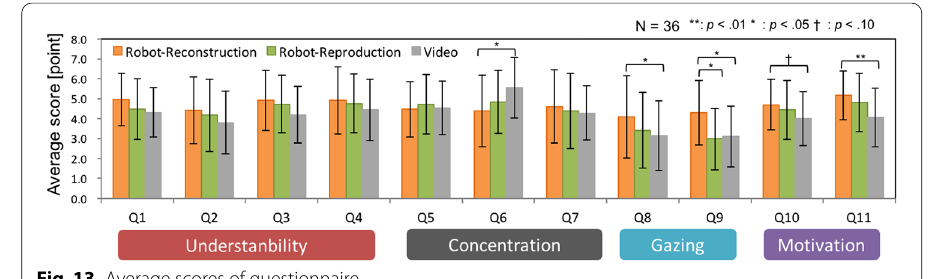
Fig. 13 Average scores of